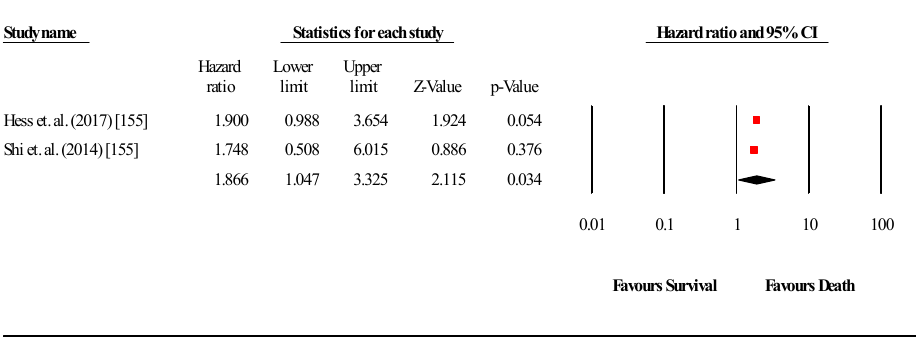
Figure 6. Forest plot for miR-155 association with OS.